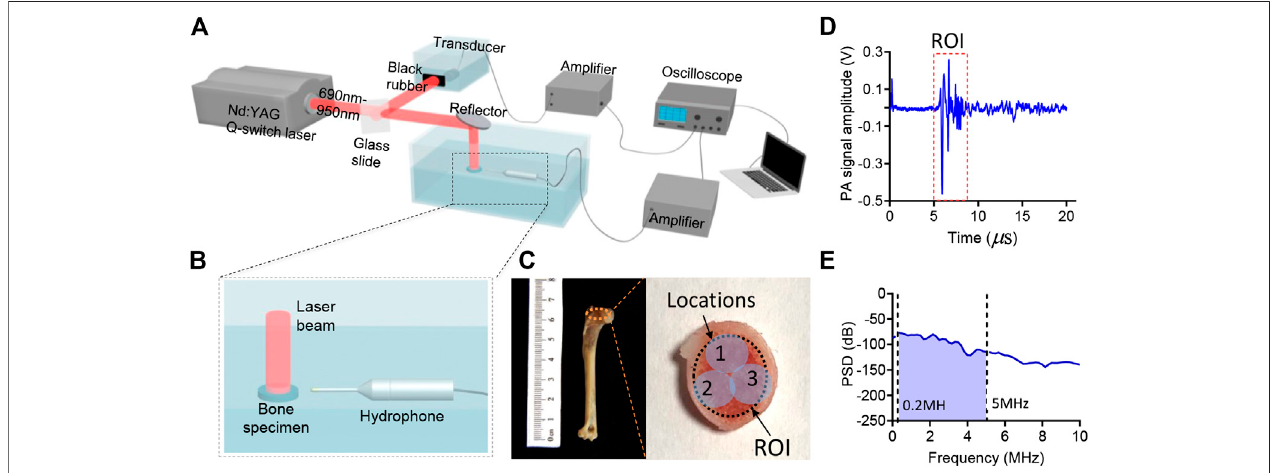
FIGURE1|(A,B) Theschematicdiagramoftheexperimentsetup. (C) Thephotographofthebonesample. (D) AnexampleofthePAsignalgeneratedbythebone specimen. (E) An example of the power spectrum density (PSD) of the PA signal generated by the bone.